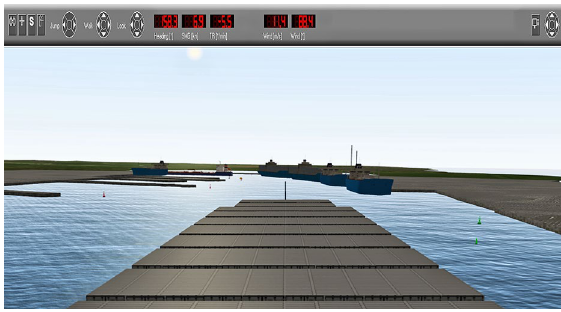
Fig. 5. The entry of a container vessel ( L = 295 m) to the turning basin in Malkų Bay (visual view)